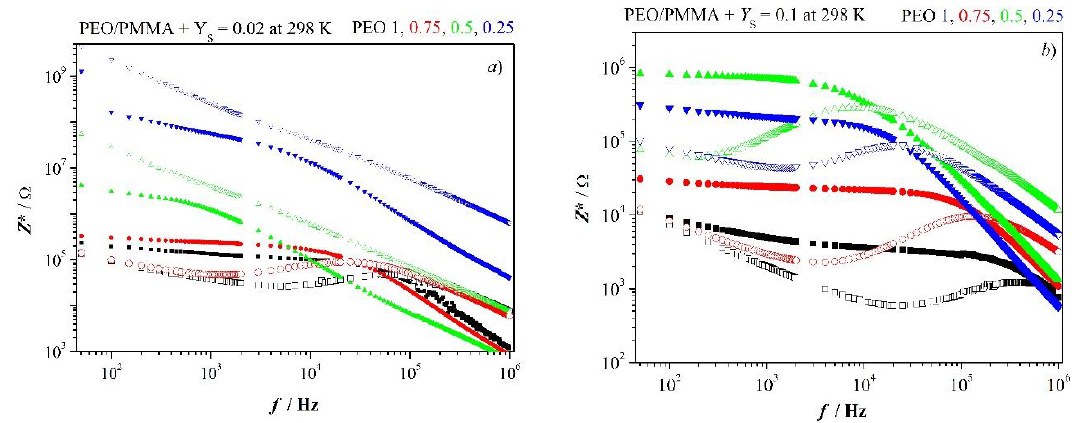
Figure 3. Impedance spectra for blends PEO/PMMA 1/0, 0.75/0.25, 0.5/0.5 and 0.25/0.75, Z’ solid marker; ( a ) Y S = 0.02, ( b ) Y S = 0.1.